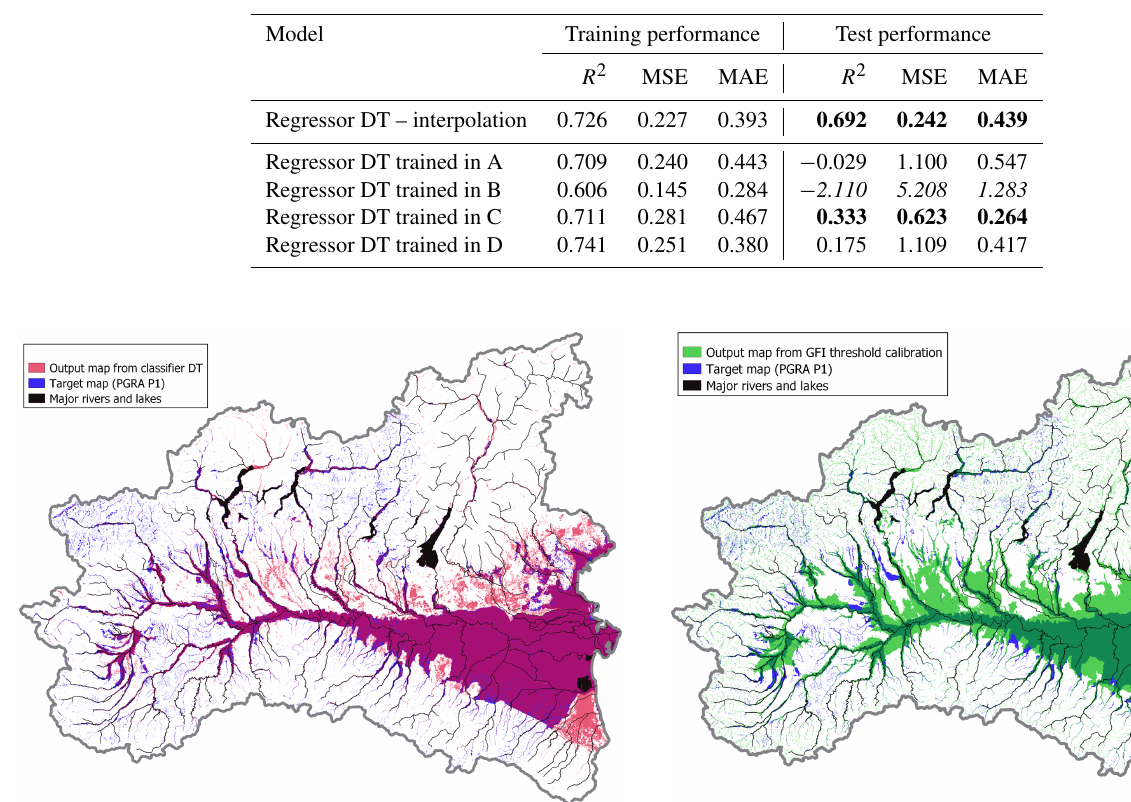
Table 2. Regression problem: performance metrics for the multivariate water depth output maps obtained with the regressor DTs (target flood hazard map: JRC 100); the best testing metrics values are reported in bold, the worst ones in italics.